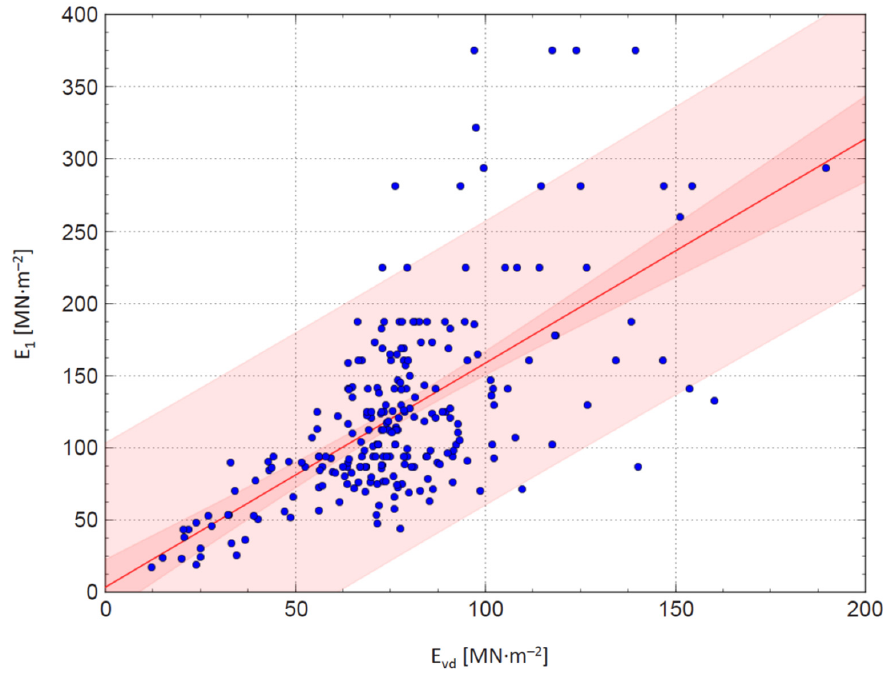
Figure 3. Linear regression for the values of dynamic deformation modulus E vd (LFWD Zorn, type ZFG 3000 GPS, 300 mm diameter loading plate, 10 kg drop weight), and primary deformation modulus E 1 (PLT, 300 mm diameter loading plate) for the entire data set included in the study (n = 245, r = 0.64).